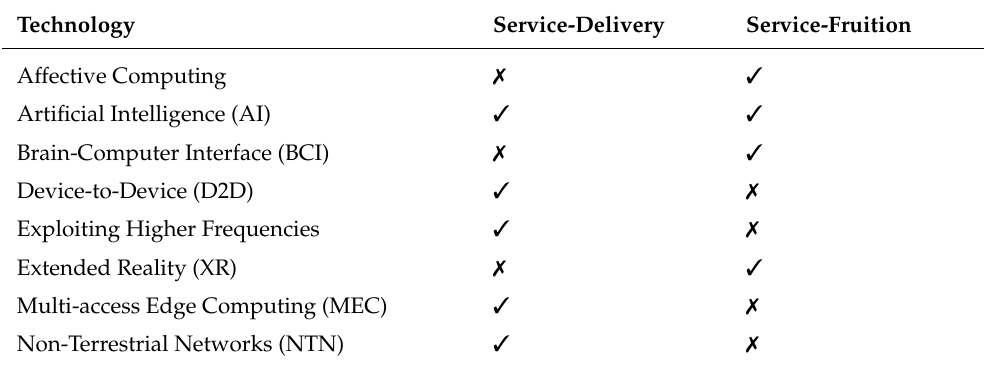
Table 1. Classification of technologies based on the mastered type of Digital